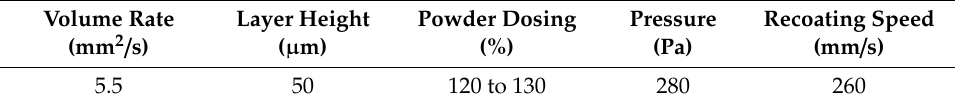
Volume Rate (mm 2 /